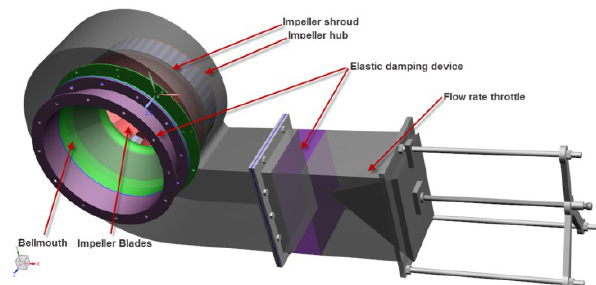
Figure 1. Component representation for the test fan.